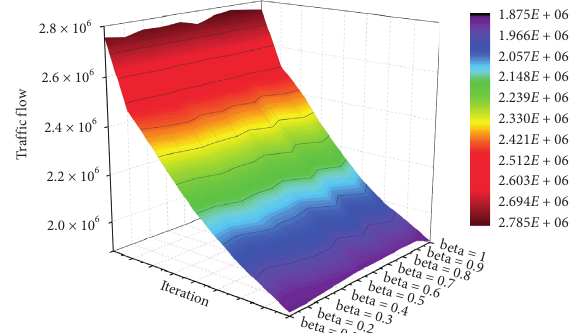
Figure 14: The change trends of traffic flow with different beta